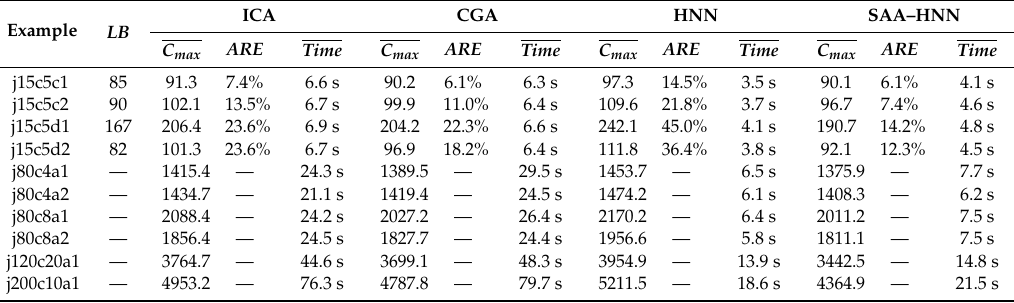
Table 2. Algorithm test